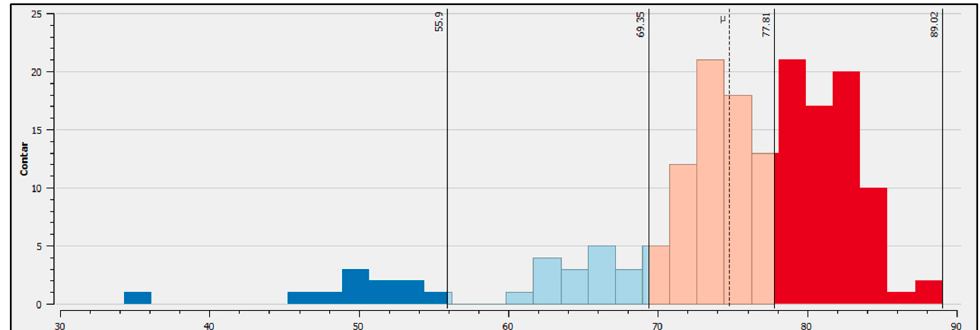
Figure 3. Histogram of similarity as regards the standard variety.